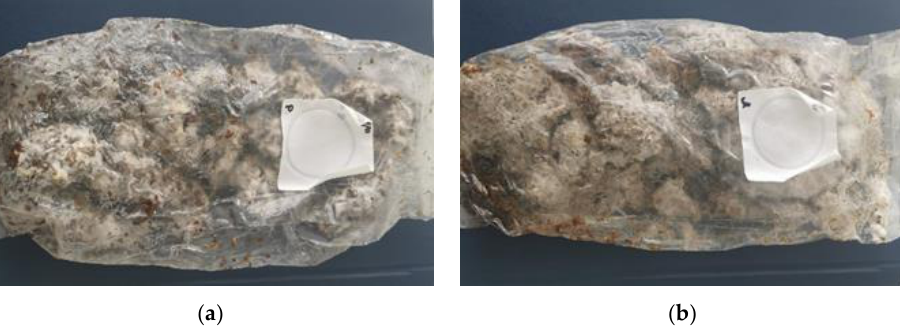
Figure 3. “ Pre - growth ” substrates — hexane extracted rose flowers ( a ) and steam distilled lavender straw ( b ). The cultivation of “pre - growth” substrates went on into special molds for another 7 days, where the fungal strain continued to increase its mycelial mass, to synthesize enzymes degrading the substrate polysaccharides and to produce metabolites, which additionally support the binding of the lignocellulose fibers of the substrate, envelope them and contribute to the final shape and structure of the biomaterial (Figure 2a).